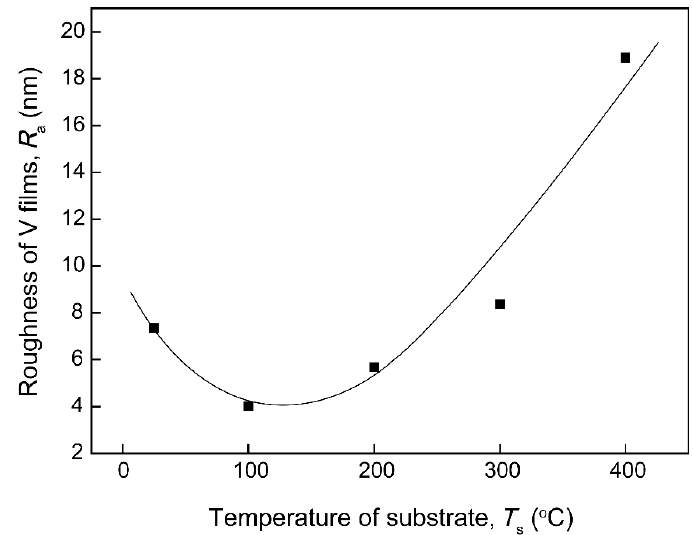
Figure 4. Effects of substrate temperatures ( T s ) on the roughness ( R a ) of V films on Si (100).